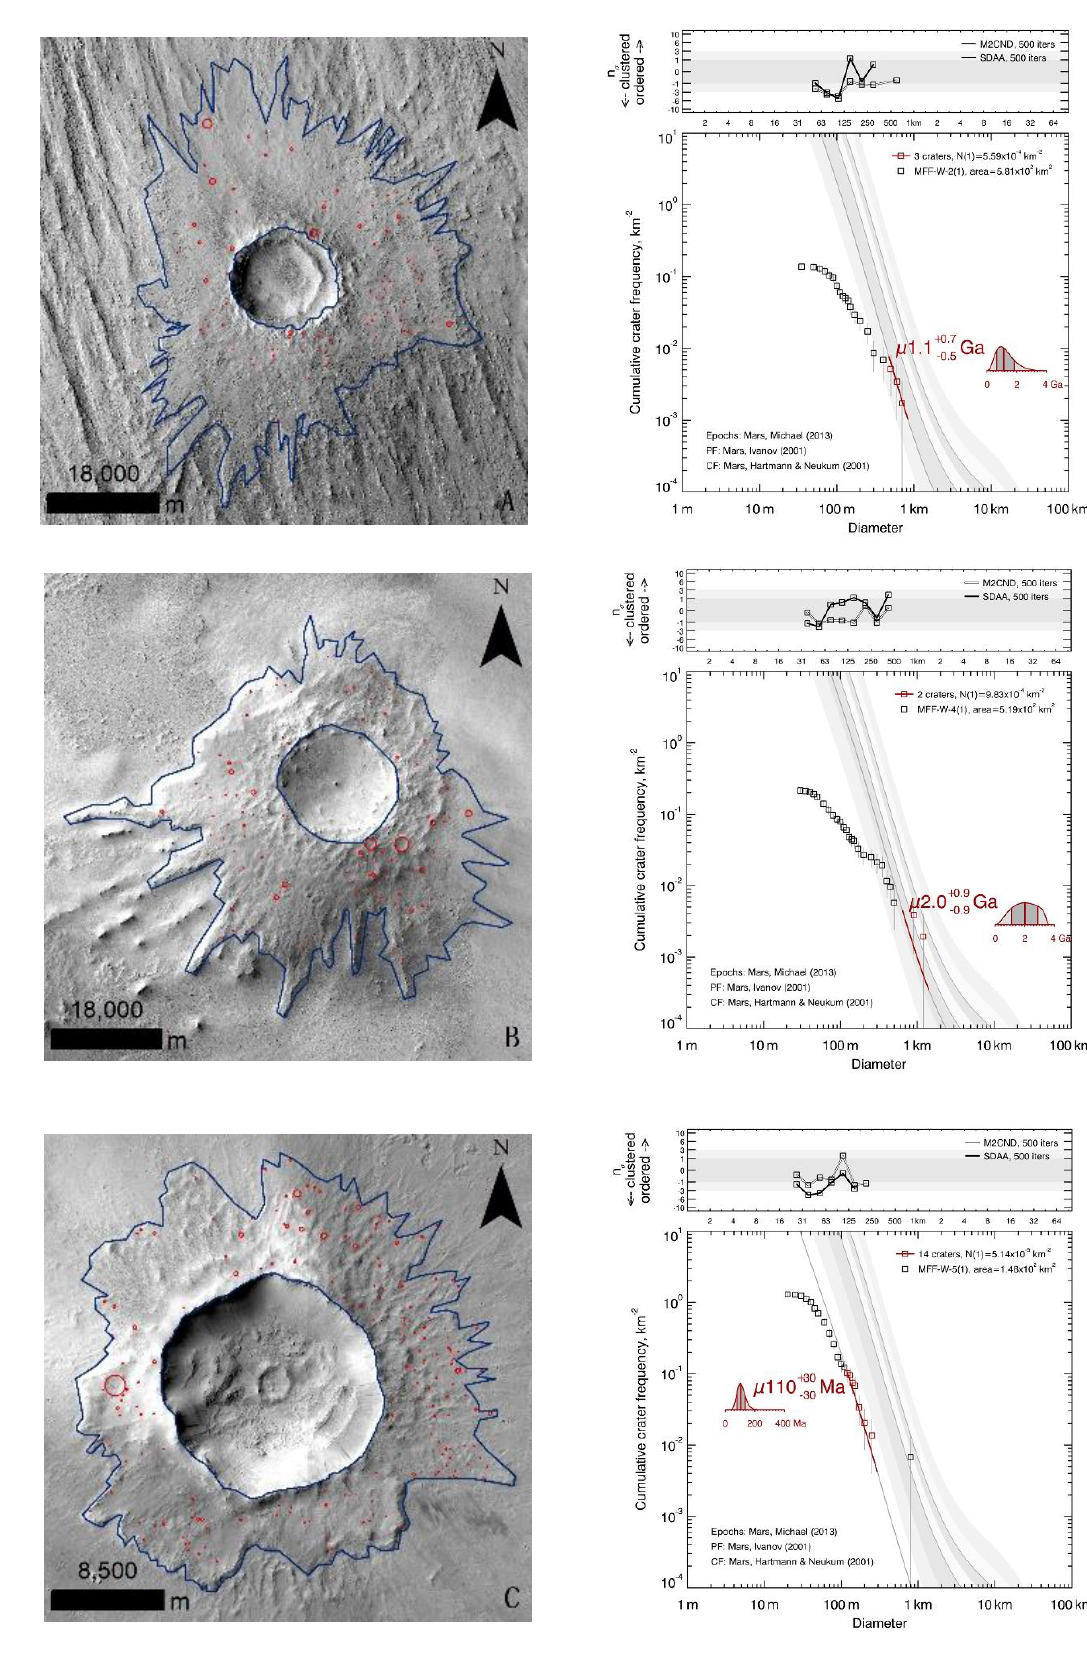
Figure 8. Dating results of layered ejecta for three layered ejecta craters with the largest group craters, and the layered ejecta have been altered by yardangs. A, B, and C are distributed in the Elysium Planitia. This analysis is also consistent with the distribution of the craters in the MFF. Figure 9 shows that there are far fewer impact craters in the yardang areas, indicating that some impact craters have been removed by the yardangs. Therefore, most yardangs in the MFF may have been active in recent history, although the climate conditions changed for some currently unknown reasons, and the yardangs’ development has ceased in some areas.